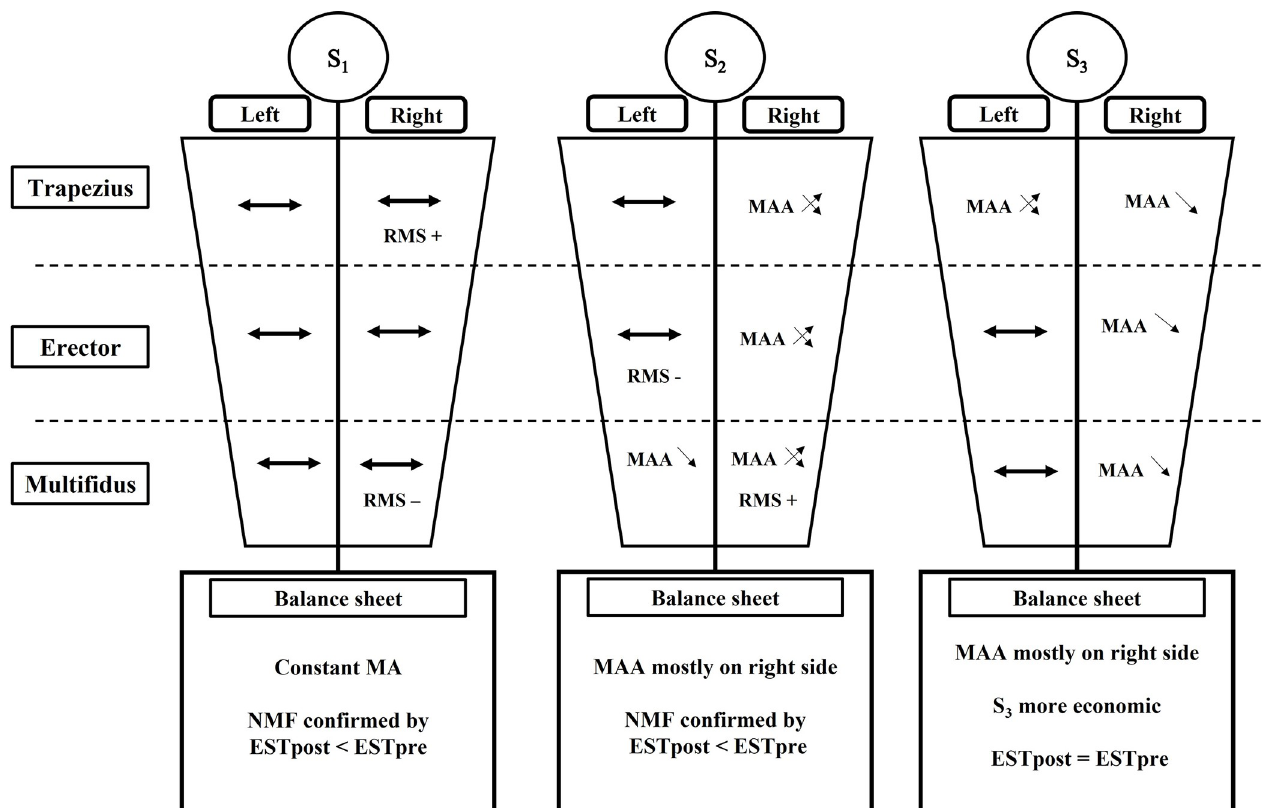
Fig 9. Schematic representation of muscular activity evolution of back muscles during the driving task for the three tested seats. With the S 1 seat, the muscular activity remains mostly stable (horizontal bold arrow) for all muscles while there is muscular activity adjustments (MAA) for the two other seat. For a same seat, crossed arrows represent fluctuation of muscular activity during the driving task; down arrows represent diminution of muscular activity with driving time. Moreover, RMS+ and RMS- are indicated when for the same muscle a seat induces respectively higher or lower muscular activity compared to the other seats for most of road